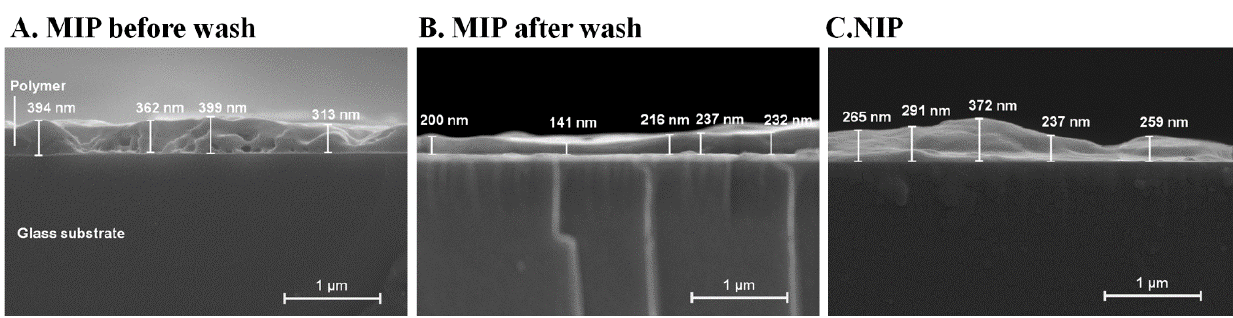
Figure 8. Cross-sectional SEM images of polymers before removing HSA ( A ), after removing HSA ( B ), and NIP ( C ).